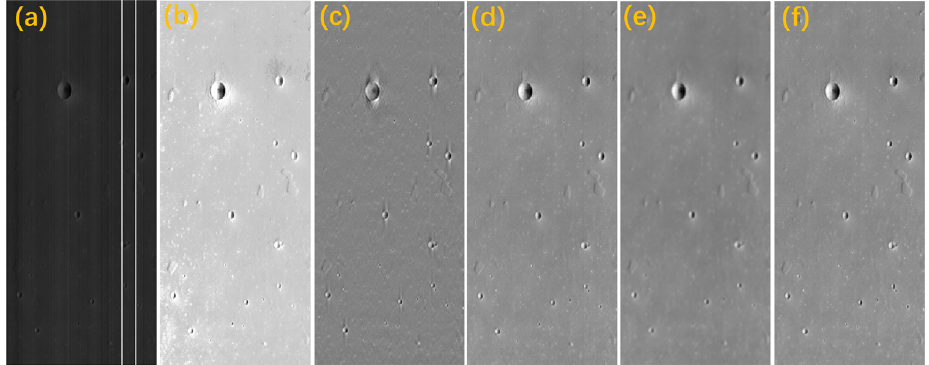
Figure 13. Correction results for the MMS N-WIR (central wavelength of 2433.7 nm) in-orbit data from linear stretched images. ( a ) Original image, ( b ) HM, ( c ) BW, ( d ) MM, ( e ) TV, and ( f ) the proposed method.